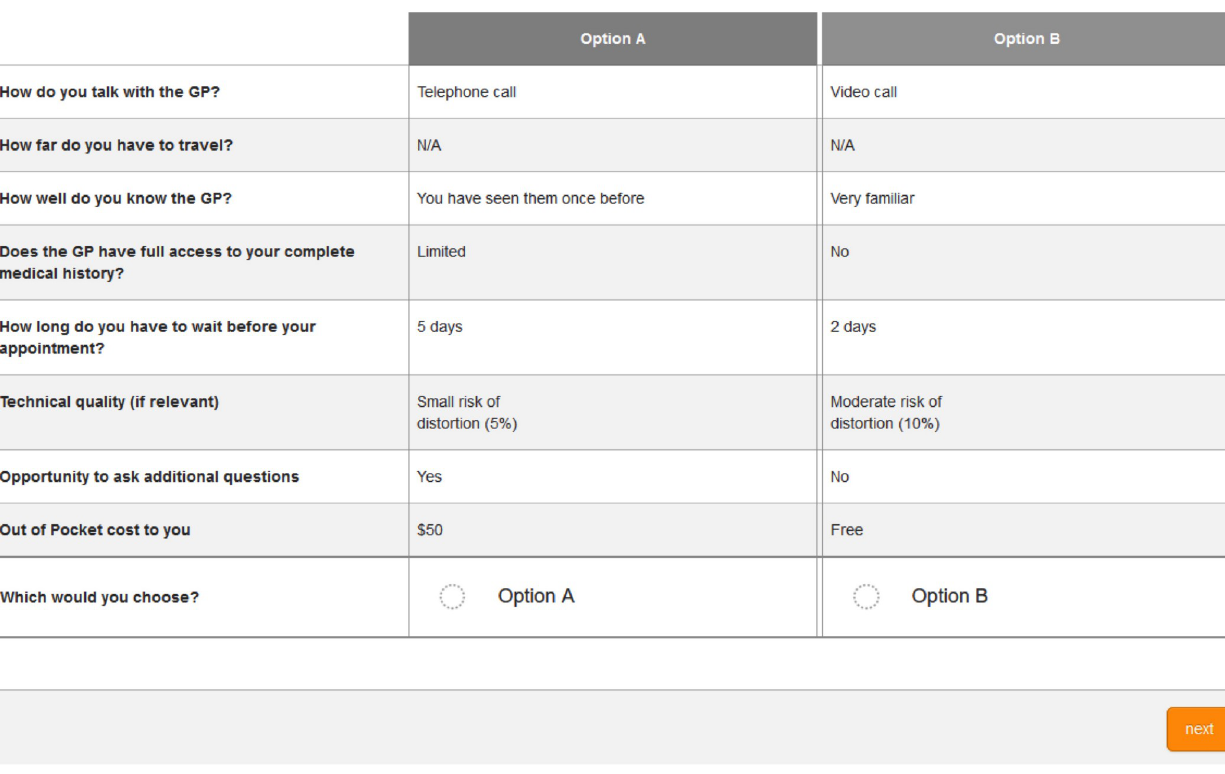
Fig 1. Example of a choice set. In this example, the participant is being asked to consider a situation where they need a repeat prescription for a condition they have. To comply with the rules about plausible combinations of levels, both options do not involve travel, and do have a risk of